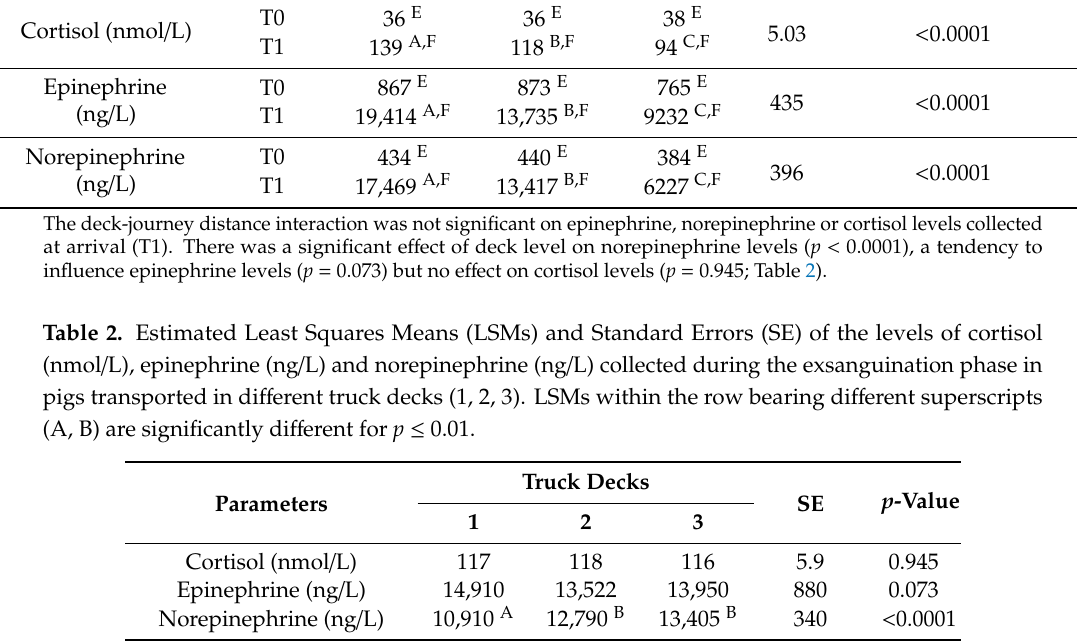
Table 1. Estimated Least Squares Means (LSMs) and Standard Errors (SE) of the levels of cortisol (nmol / L), epinephrine (ng / L) and norepinephrine (ng / L) in plasma collected before (T0) and after (T1) a journey from three di ff erent farms towards the same slaughterhouse. LSMs within the row bearing di ff erent superscripts (A, B, C) are significantly di ff erent for p ≤ 0.01. LSMs within the tested hormones and in the same column followed by di ff erent superscripts (E, F) are significantly di ff erent for p ≤ 0.01. J1 (11 h) Parameters Time Cortisol (nmol / L)